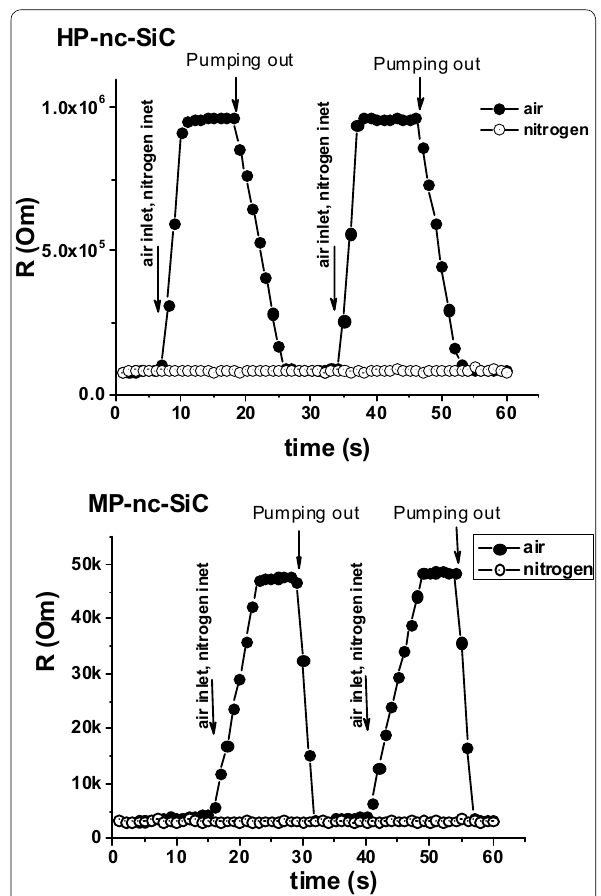
Fig. 4 The dependence of the electrical resistance of films of the series MP-nc-SiC ( a ) and HP-nc-SiC ( b ) on the interaction with air ( ● ) and pure nitrogen ( ○ ) at atmospheric pressure, at a temperature of 700